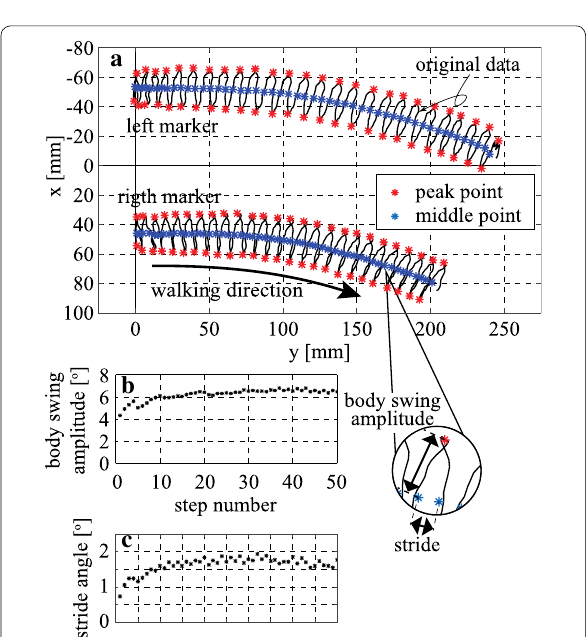
Fig. 15 Typical trajectories of the two markers and variations of body swing amplitude and stride angle ( L heating